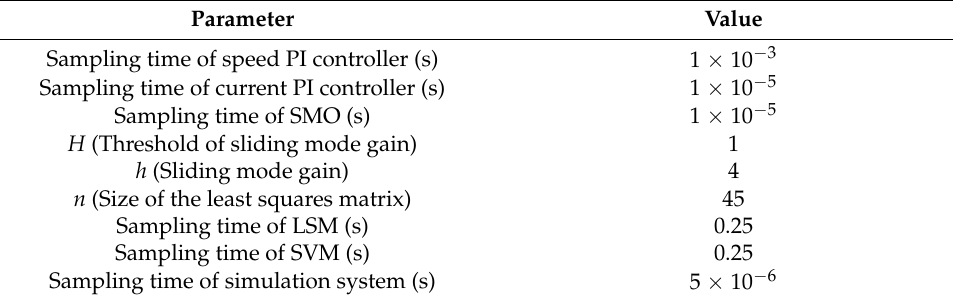
Table 3. The parameters for fault diagnosis.